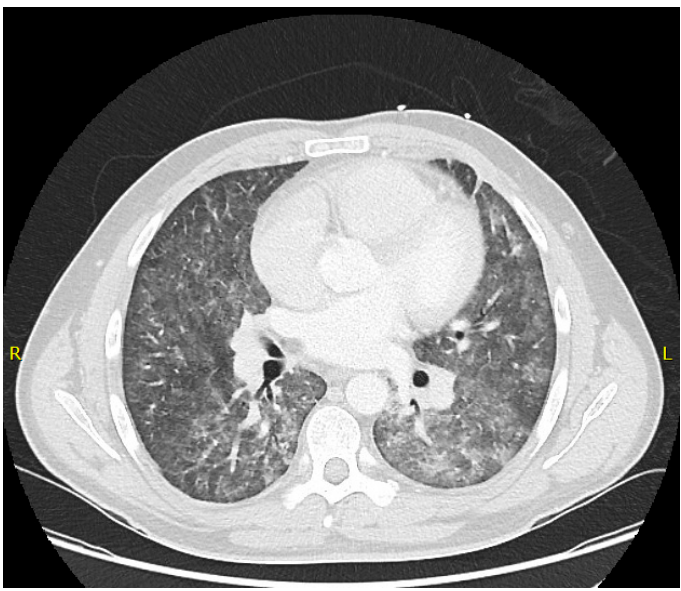
Figure 1. A computerized tomography (CT)-Thorax image showing centrilobular ground glass opacification in an HIV-infected patient with Pneumocystis pneumonia.